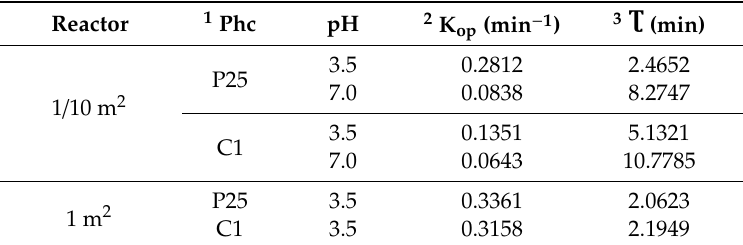
Table 3. Data on the degradation kinetics of 6-MP by solar heterogeneous photocatalysis with two TiO 2 photocatalysts in two reactors with different surfaces *.